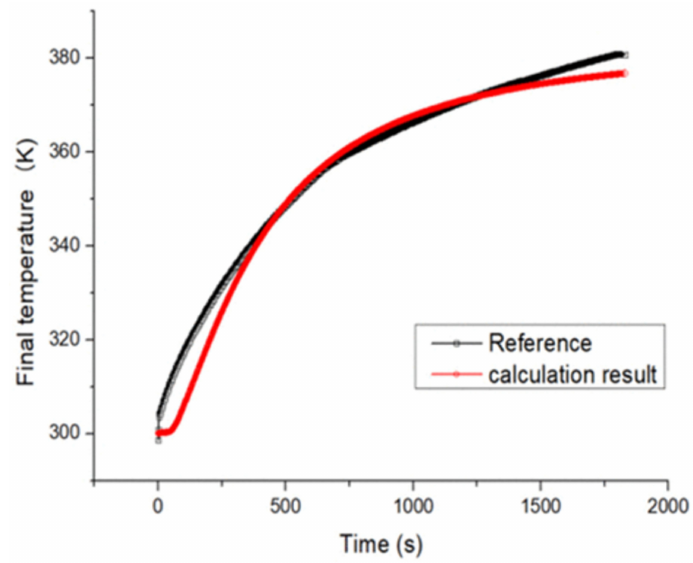
Figure 4. Final temperature of ref. [21] and the fitting formula of calculation result.